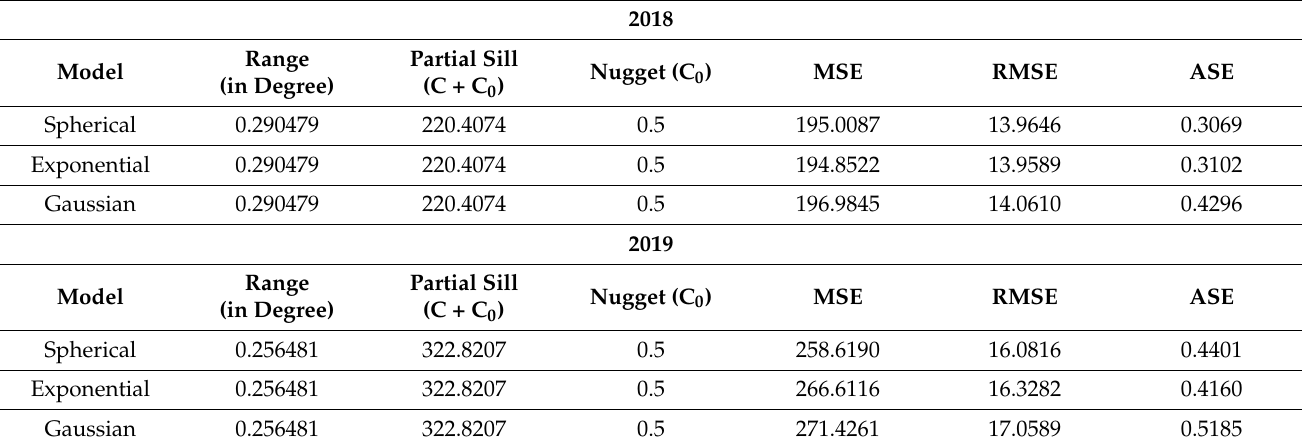
Figure 7. Semivariogram of different experimental models of FRD severity in 2018 and 2019. OK maps were generated using model information. The colored lines and blue dots represent the different models and model parameters. Table 2. Semivariogram experimental model parameters and cross-validation results. OK maps were generated using model information.